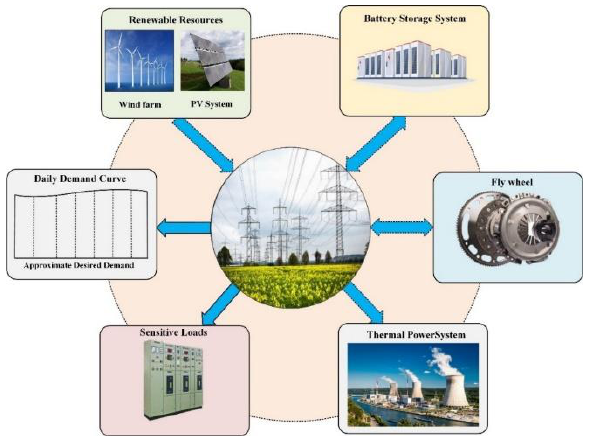
Figure 1. Overview of the system .